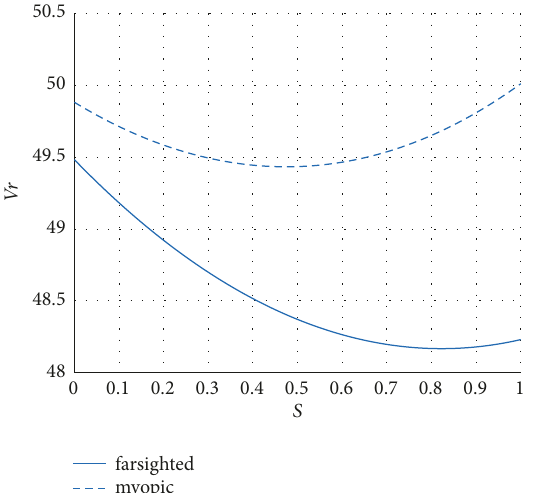
Figure 2: The profits of the retailer as 𝑆 increases.